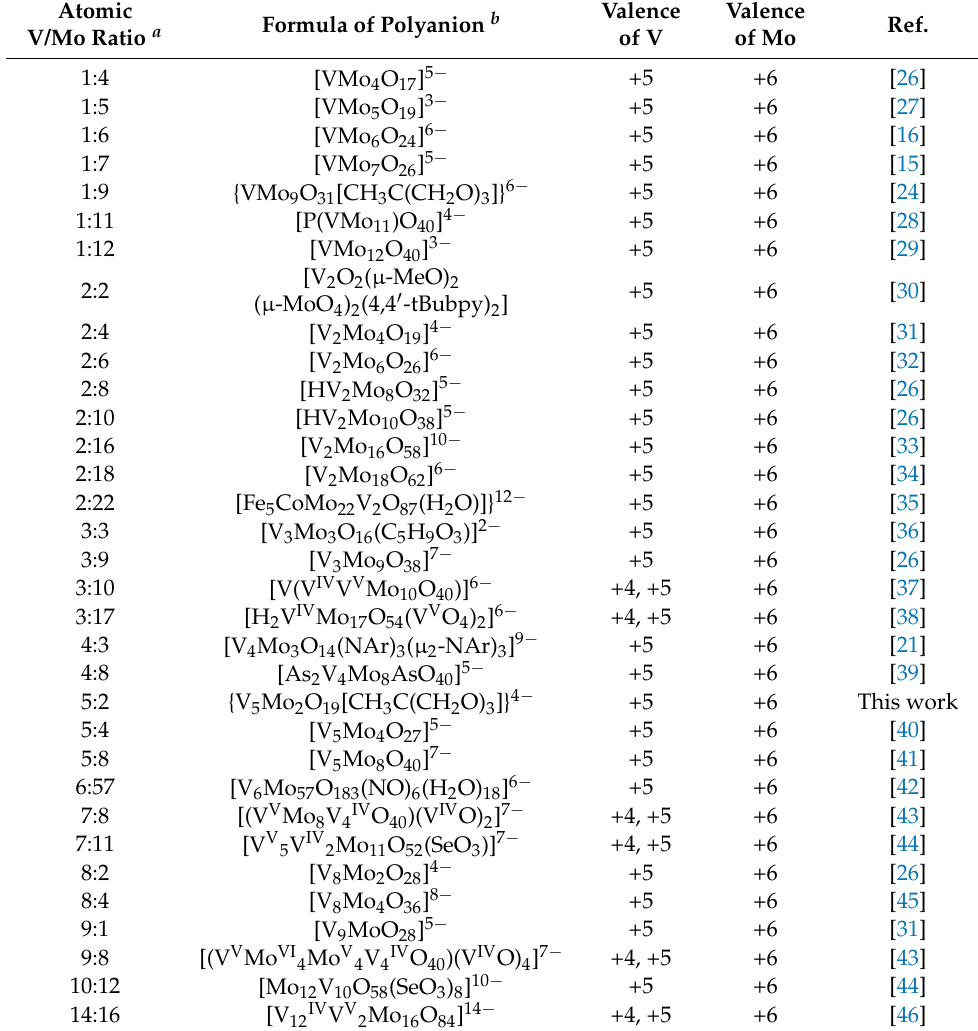
Table 1. Summary of atomic V/Mo ratios in some classical